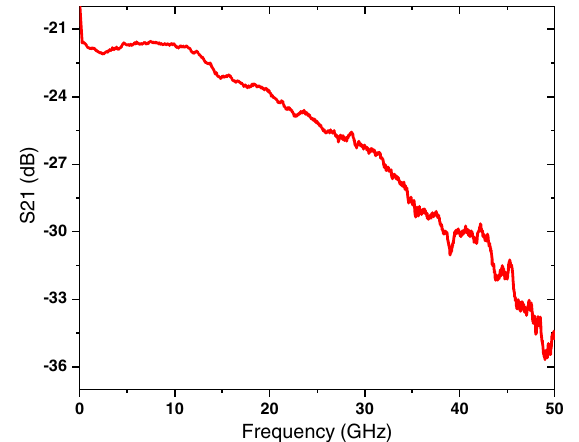
FIG. 7. S21 curve of CDM. A 3-dB bandwidth of about 21 GHz is achieved.